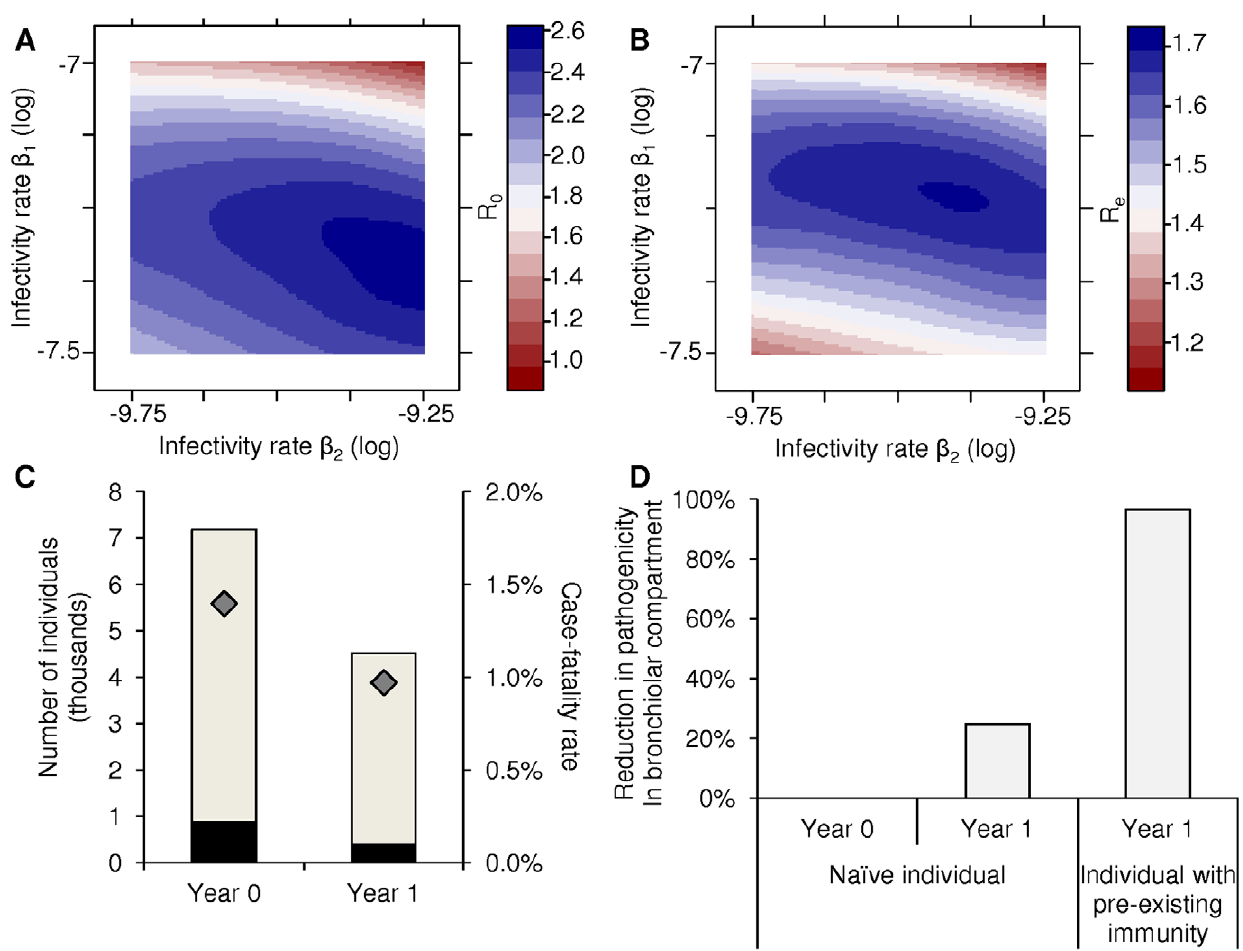
Figure 4. Optimal patterns of tissue tropism and associated morbidity and mortality burdens. Contour plots of influenza virus reproductive number (color scales) in an immunologically naı¨ve population (R 0 ; A ) and in a partially-immune population (R e ; B ) are drawn when the infectivity rates b 2 (x axis) and b 1 (y axis) are varied. In all cases, the infectivity rate b 3 is kept constant and equals the lowest infectivity rate in the explored range (10 2 10 h 2 1 ). Note that the optimal tissue tropism differs in an immunologically naı¨ve and in a partially-immune population. C. The total number of cases per 10 000 individuals (light grey bars) and the number of fatal cases per 100 000 individuals (black bars) are represented for the influenza virus with optimal tissue tropism in an immunologically naı¨ve population (year 0) and for the influenza virus with optimal tissue tropism in a partially-immune population (year 1). Their respective case-fatality rate is indicated by a dark grey diamond. D. The percentage reduction in pathogenicity in the bronchiolar compartment (P 2 ) of the influenza virus with optimal tissue tropism in a partially-immune population is shown in a naı¨ve individual and in an individual with pre-existing immunity in year 1 compared to that of the influenza virus with optimal tissue tropism in an immunologically naı ¨ ve population (year